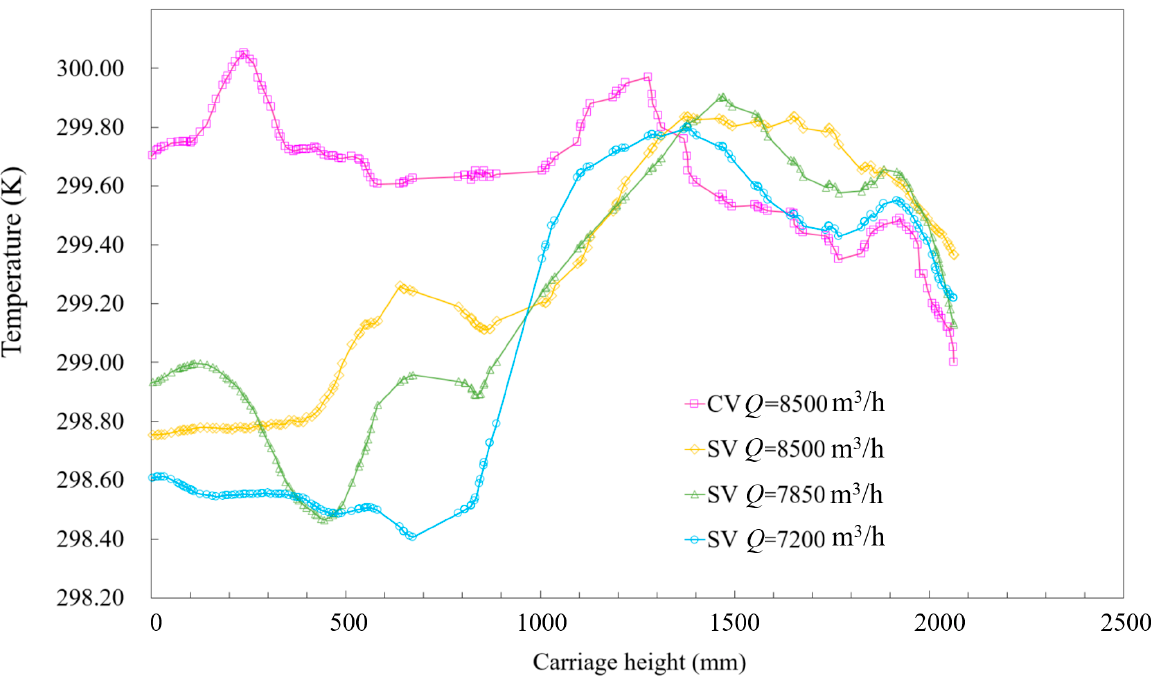
Figure 9. Comparison of temperatures at the midline between the seated and standing passengers for different Q values.